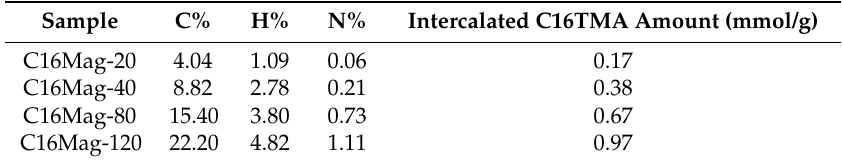
Table 1. C, H, and N elemental analysis of organo-magadiites prepared with different initial C16TMABr loading